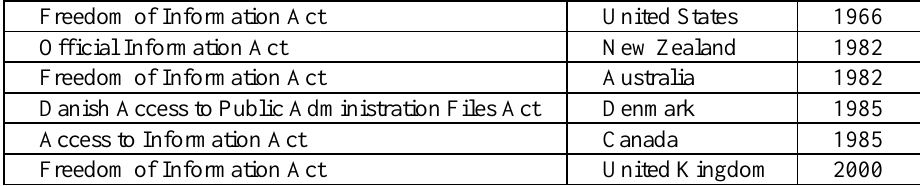
Table 1: Some FOIA